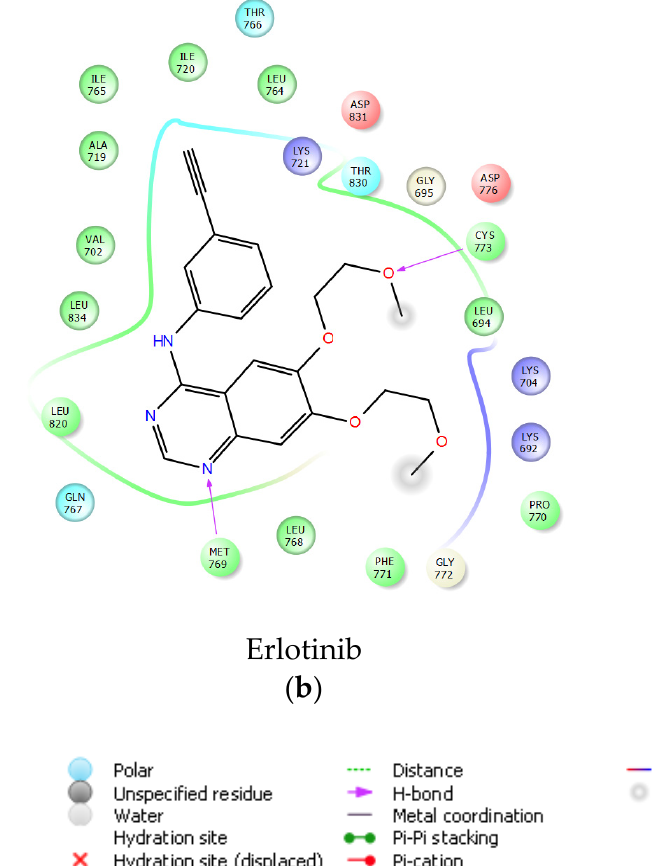
Figure 4. Docking poses of compound 4 , compound 1, and erlotinib ( a ) (colored in orange, blue purple, and turquoise, respectively) (green dashes: π -cation interaction, yellow dashes: hydrogen bonding) and docking interactions of compound 4 , compound 1 , and erlotinib ( b ) in the ATP binding site of EGFR. Table 2. Predicted ADME properties of compounds 1 – 7